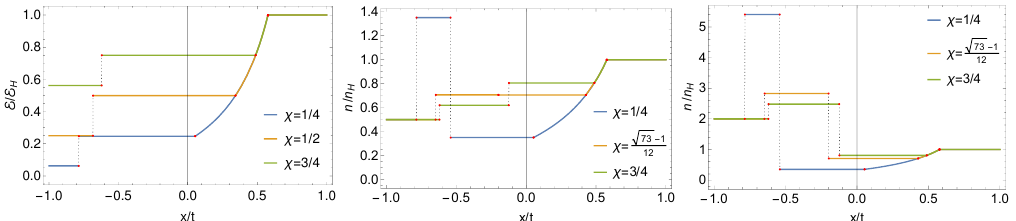
Figure 3: Energy density (left) and charge density (middle and right) for the shock + rarefaction wave solution. The rarefaction wave moving to the hot bath ap- pears on the right. This figure is to be compared to the two-shock solution displayed in Fig.